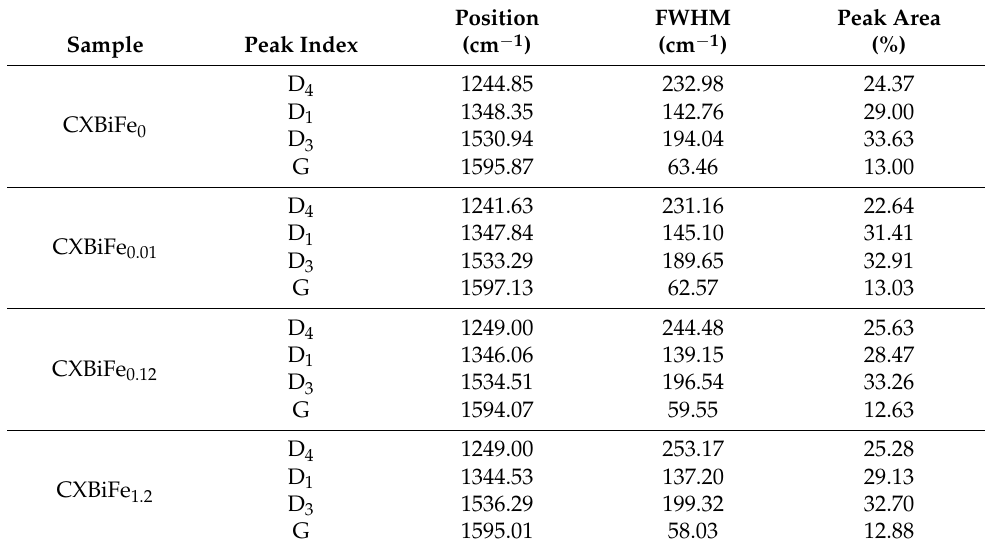
Table 2. Results obtained after a four peaks deconvolution of the D–G region of the Raman spectra.